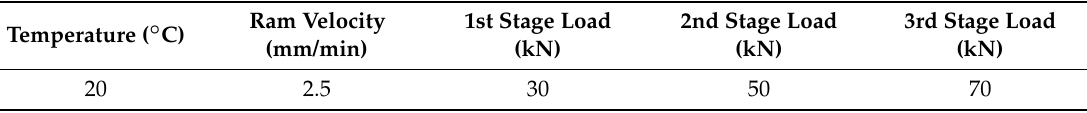
Table 1. Ring compression test conditions.